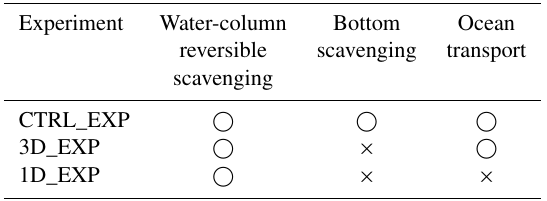
Table 3. Processes considered in additional experiments. A circle means that the process is considered, and a cross means that it is not